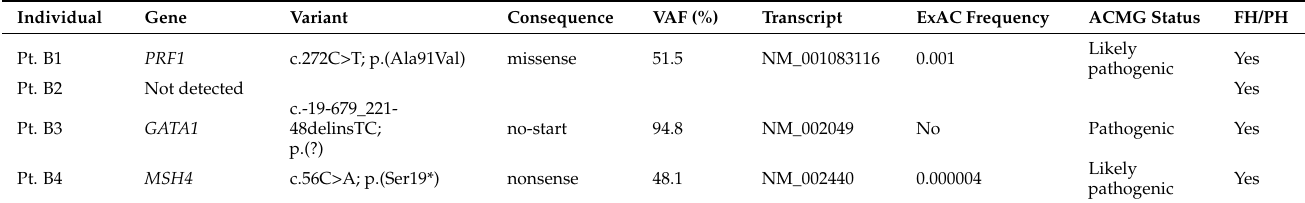
Table 3. Genes mutated in four index cases from Cohort